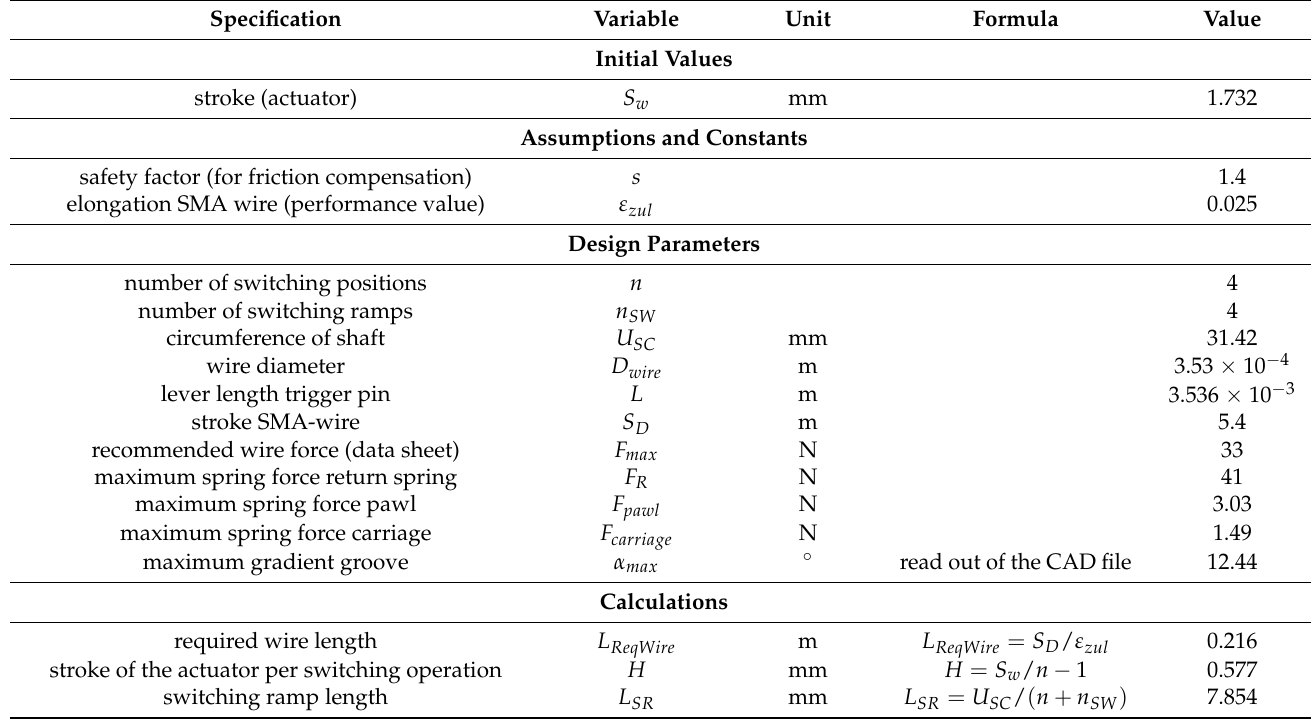
Table 4. Key figures of the developed actuator.